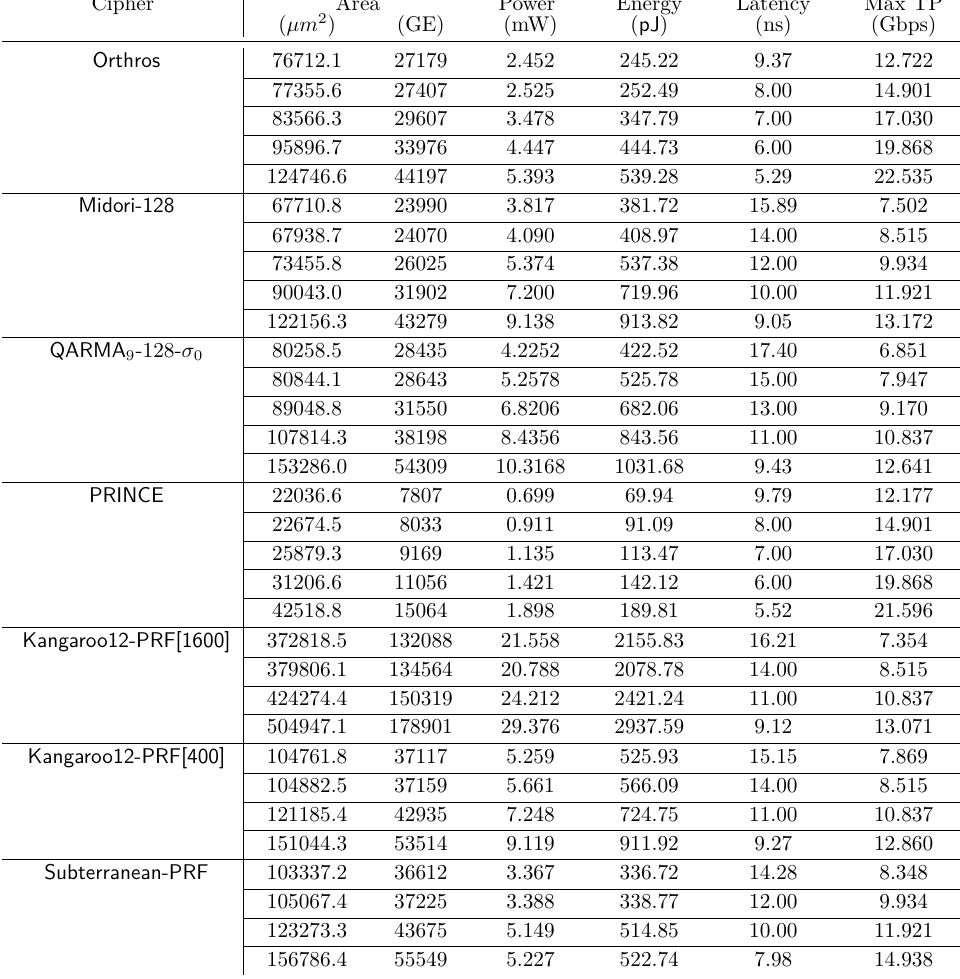
Table 18: Results for the TSMC 90nm library. Power measured at 10